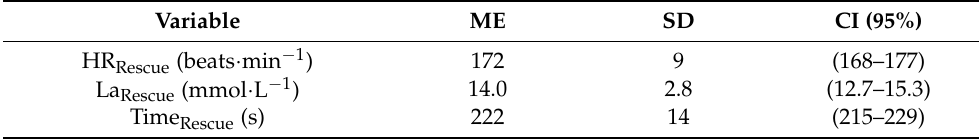
Table 3. Total descriptive data of the results obtained in the rescue test.